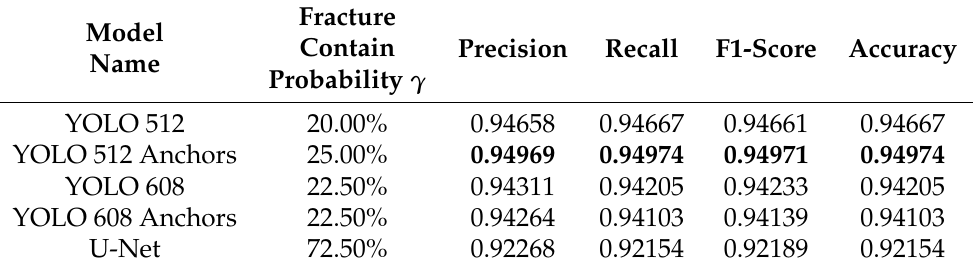
Table 2. Binary evaluation of the models on test set #1.